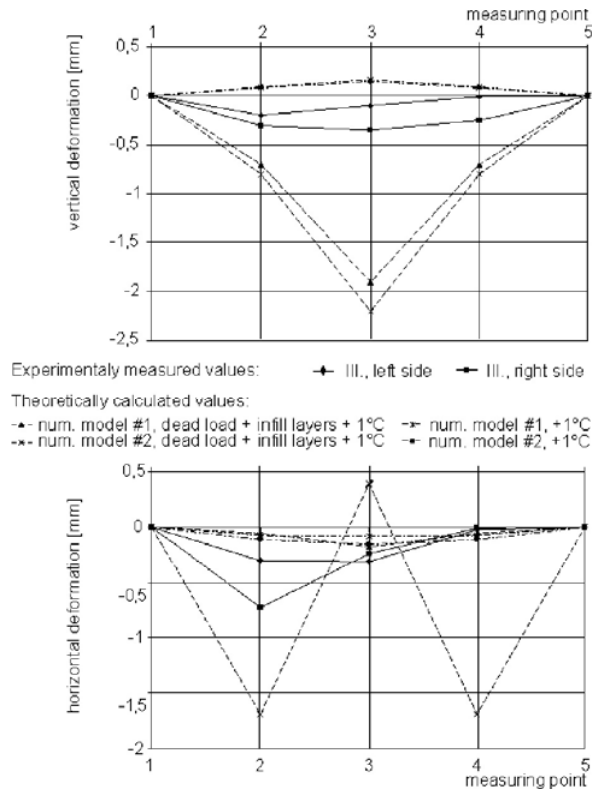
Fig 12. Comparison of vertical and horizontal deforma- tions measured and theoretically calculated (arch III, for temperature difference of +1